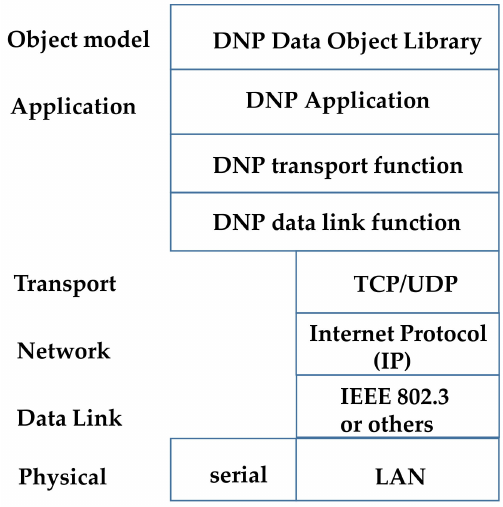
Figure 1. DNP3 protocol stack.